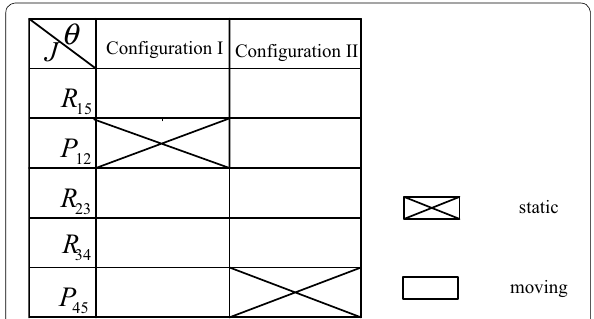
Figure 8 Metamorphic cyclogram of tablet press machine